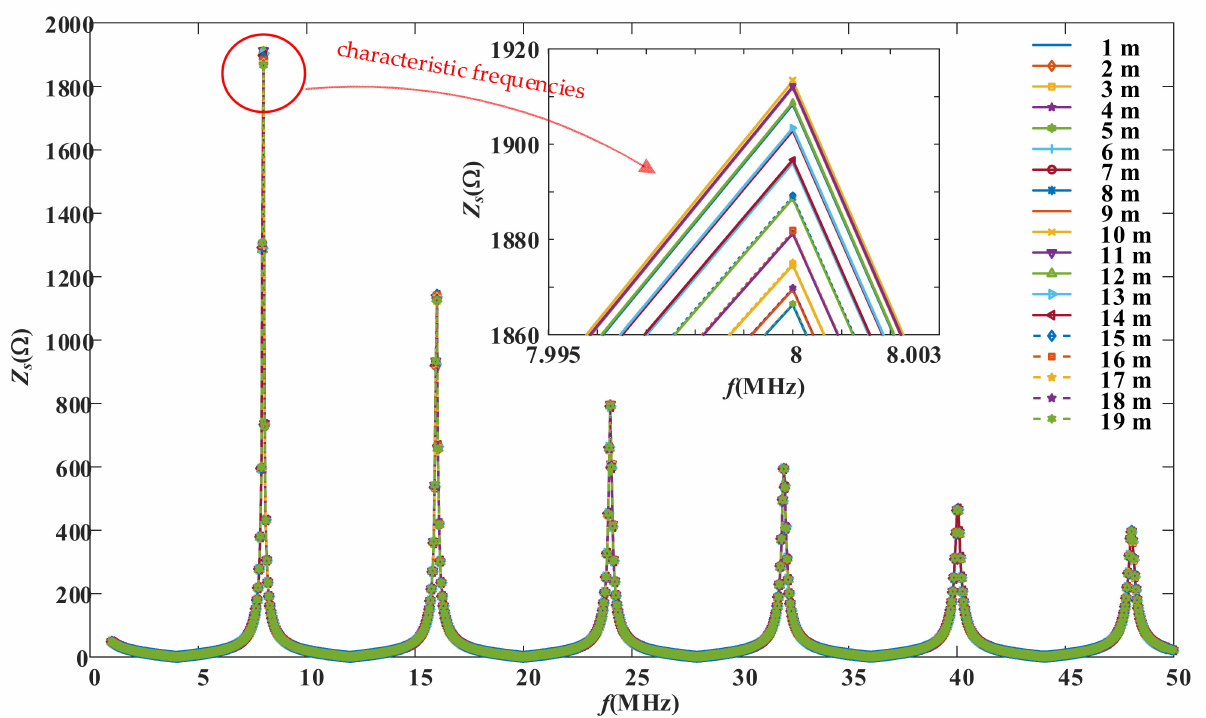
Figure 5. The impedance magnitude spectroscopy with the characteristic frequencies for the position of the degradation at 1~19 m.